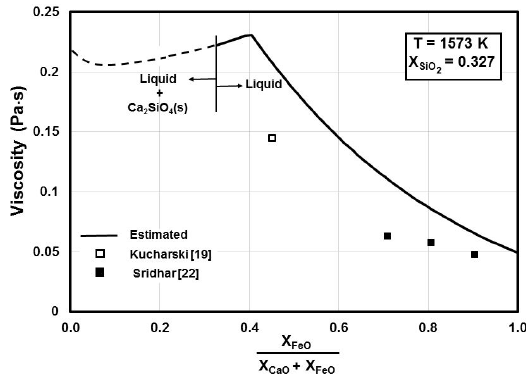
Figure 5. Isoviscosity curves (Pa ⋅ s) of SiO 1573 K.